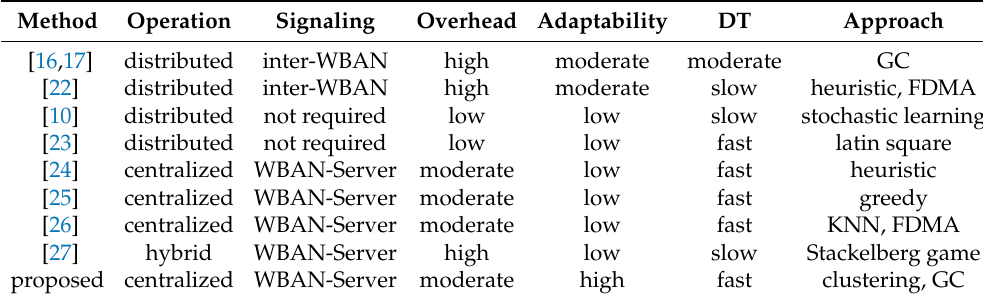
Table 1. Comparison of the channel allocation methods (GC represents a graph coloring and DT represents decision